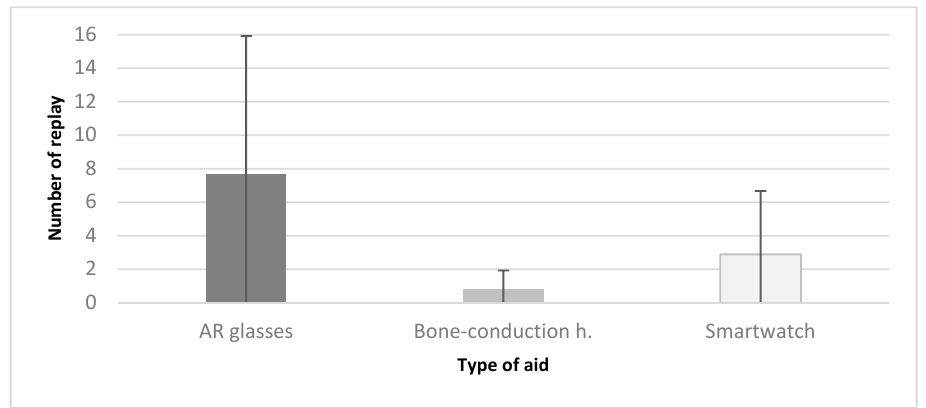
Figure 9. Number of times the replay button was pressed. Vertical bars represent standard deviations